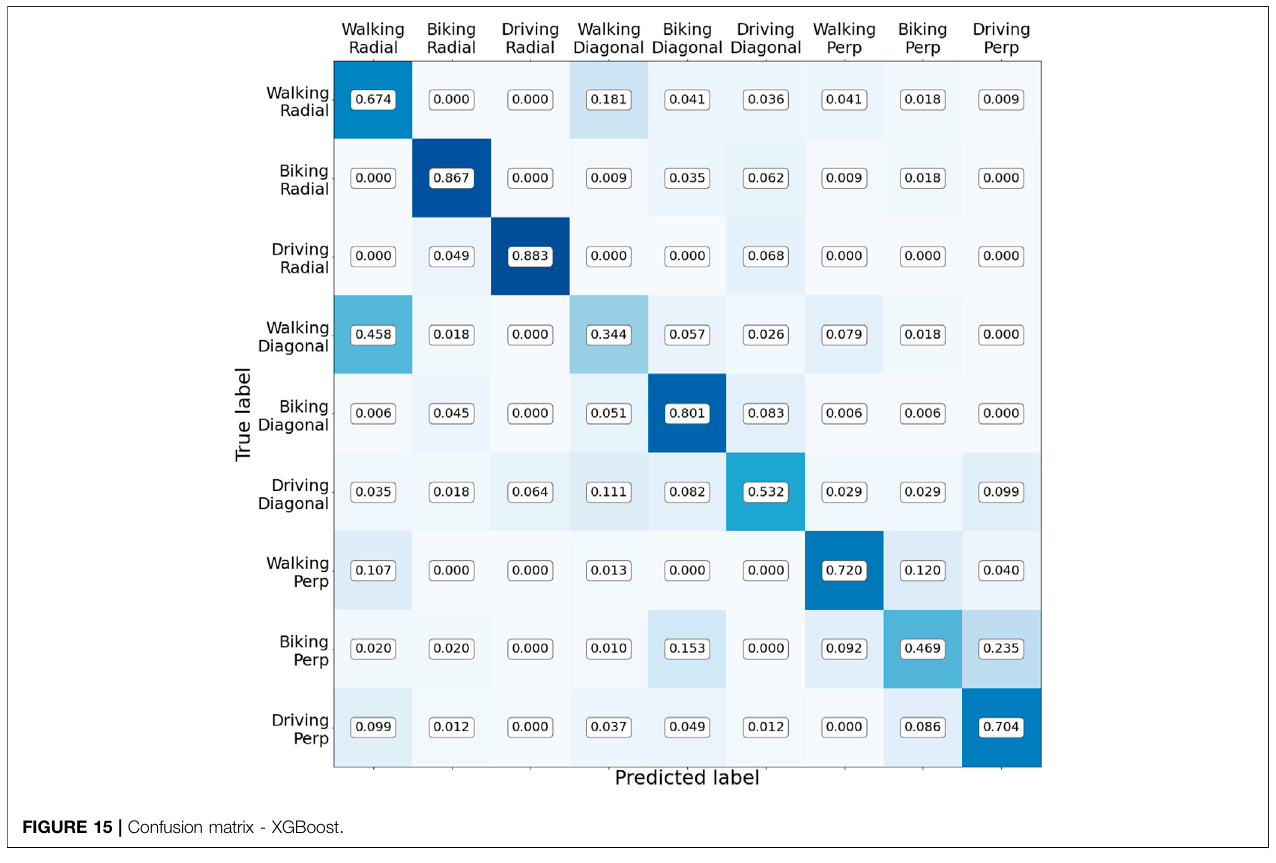
FIGURE 15 | Confusion matrix - XGBoost.